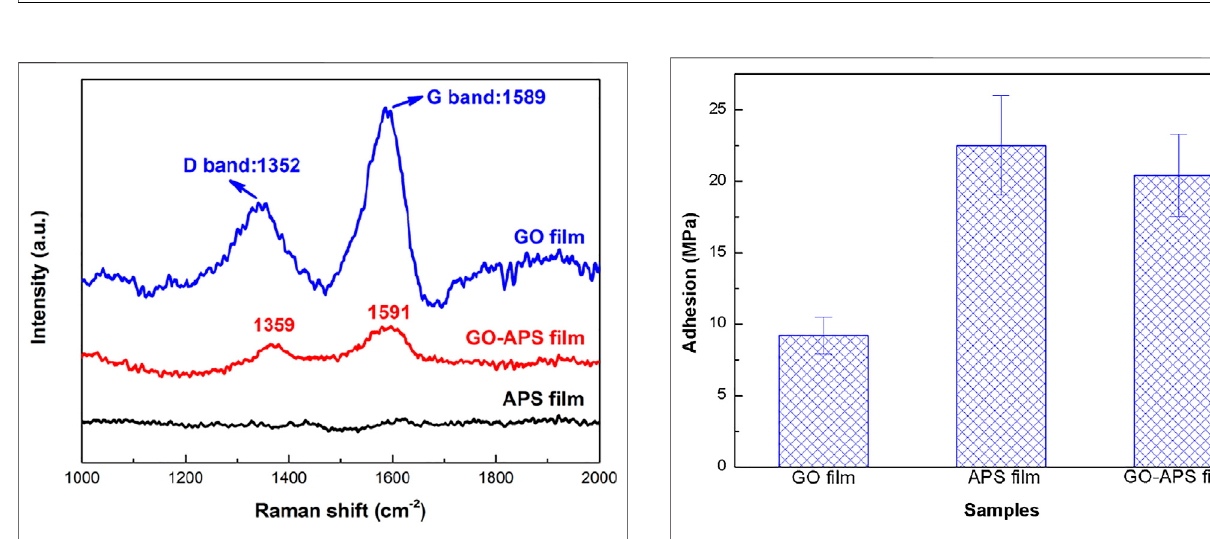
FIGURE 6 | Adhesion results of the pull-off tests of GO, APS, and GO- APS fi